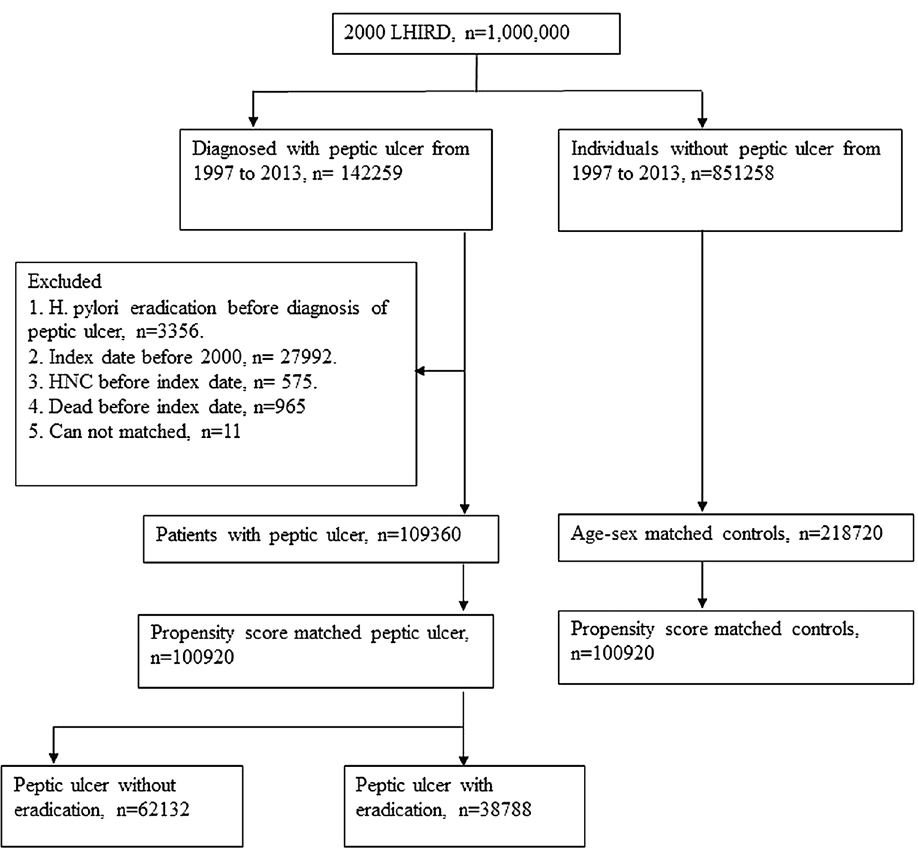
Figure 1. Flow diagram of identification and enrollment of the study patients. LHID = Longitudinal Health Insurance Database; H. pylori ., Helicobacter pylori ; HNC = Head and Neck Cancer.